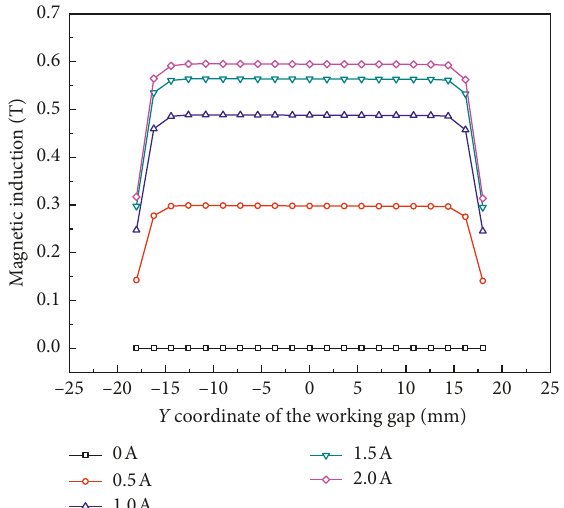
Figure 10: Magnetic induction curve in the working channel of the MRE cylinder.